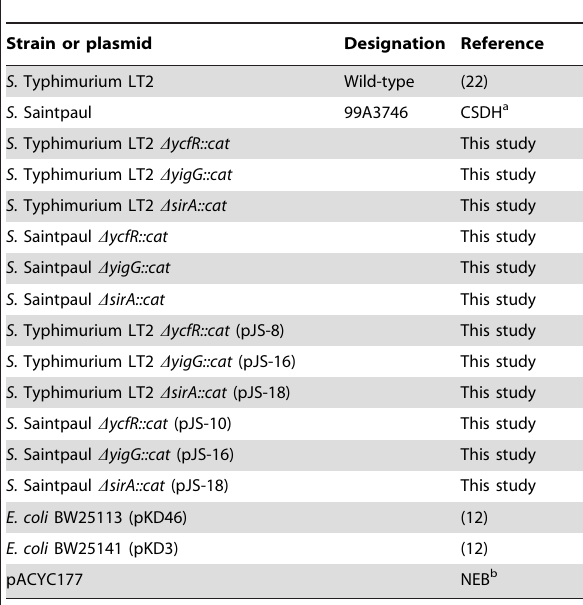
Table 1. Bacterial strains and plasmids used in this